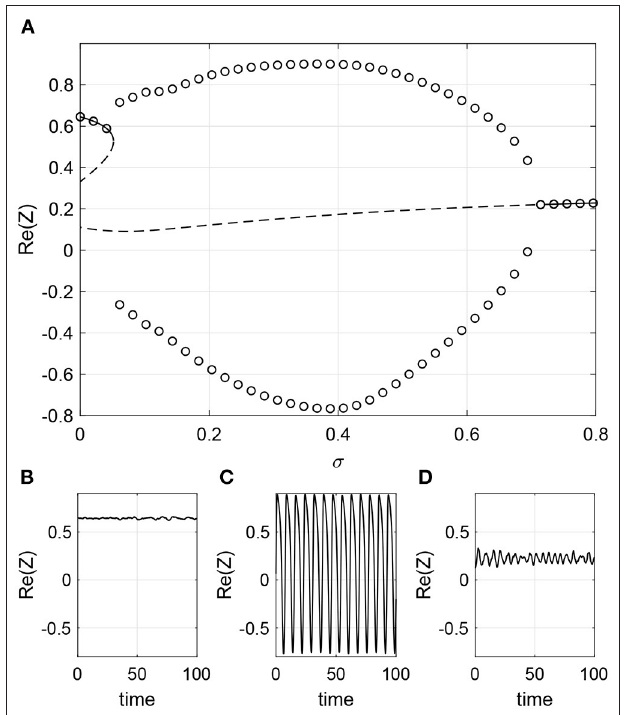
σ ( ˆ k in FIGURE 10 | Phase dependency β ( k in ) 1). (A) Solid line: stable fixed = + point of Equation (40); dashed line: unstable fixed point. Circles: maximum and minimum over one period of Re( Z ). Re( Z ) calculated using (30) for (B) σ (C) σ 0.4, and (D) σ 0.8. Other parameters: = = 1 0.05, ω 0 1, ǫ 0.8, m 100, M 400, N 2,000. = = = = = =